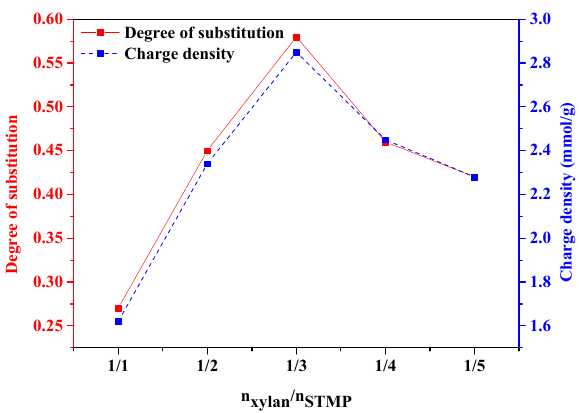
Figure 3. The effect of molar ratio of xylan/STMP (n xylan /n STMP ) on the degree of substitution and charge density of phosphorylated xylan (conducted at 80 °C for 3 h).